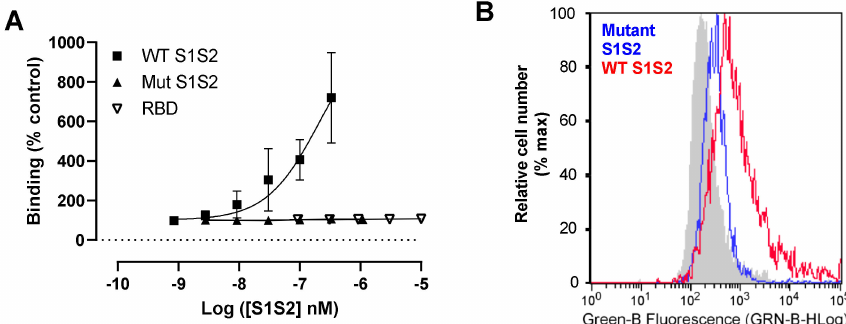
Figure 6. S1S2 interaction may require the furin cleavage site. ( A ) Dose–response curve for wtS1S2, mS1S2 or RBD to RT4 cells. RT4 cells were incubated with wtS1S2, mS1S2 or RBD at the stated concentrations for 60 min at 37 ◦ C, before staining with anti-His6 secondary antibody labelled with Dylight 488. The data are the means ± SEM of 3 - 6 independent experiments performed in duplicate. ( B ) Representative histogram of 100 nM wild-type S1S2 (wtS1S2) or mutant S1S2) attachment to RT4